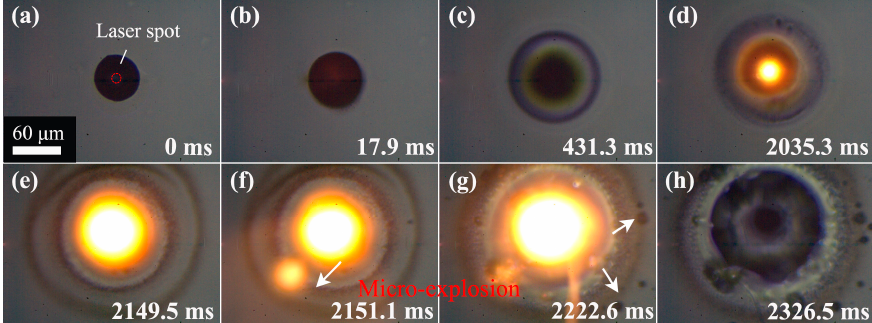
Figure 8. ( a – h ) Representative snapshots during the combustion of a single Al-Li alloy.